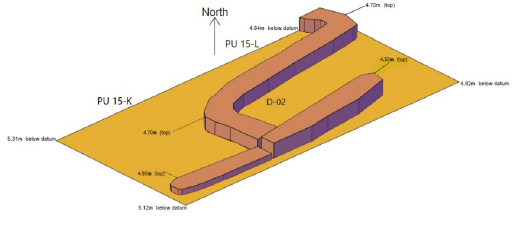
Fig 7. Planimetry of level